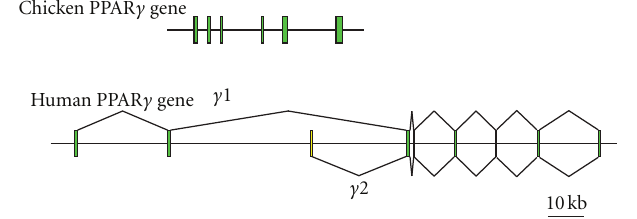
F 1: Structural organization of chicken (upper panel) and human (lower panel) PPAR genes. Exons are shown as green boxes with the 2-speci�c exon colored in 𝛾𝛾 𝛾𝛾